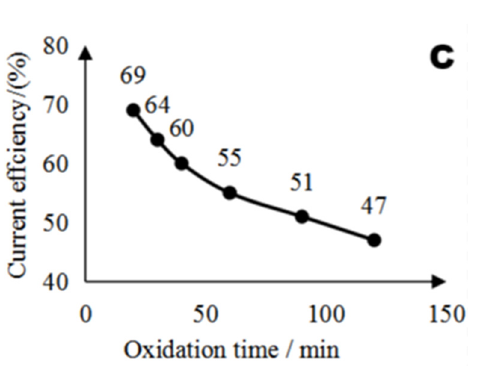
Figure 1. Relationship between current efficiency and different factors. ( A ) The relationship between current efficiency and concentration; ( B ) The relationship between current efficiency and temperature; ( C ) The relationship between current efficiency and oxidation time; ( D ) The relationship between current efficiency and current density.